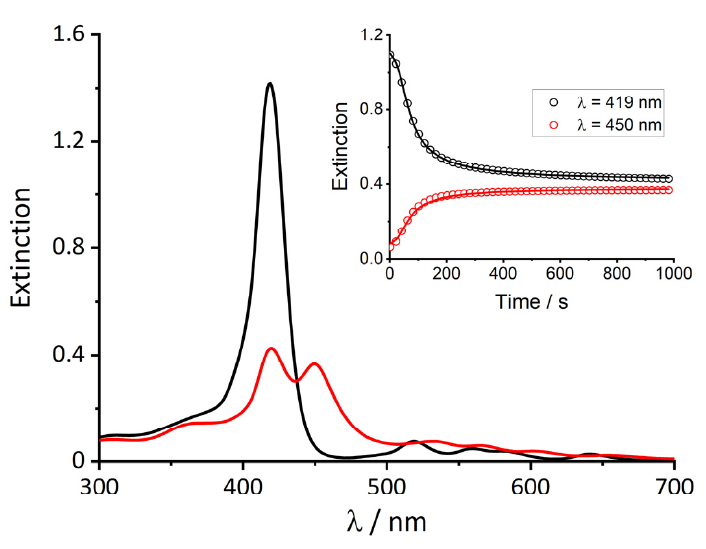
Figure 1. UV/Vis spectra of monomeric t-H 2 Pagg no salt added (black curve), and t-H 2 Pagg aggregates (red curve) obtained upon addition of NaCl. Inset: kinetic traces recorded for the decrease of monomeric t-H 2 Pagg at λ = 419 nm (black circles) and the formation of t-H 2 Pagg aggregates at λ = 450 nm (red circles). Solid lines represent the result of the global fit obtained with Equation (1) ( k 0 = 0.0036 ± 0.00097 s − 1 , k c = 0.0237 ± 0.0007 s − 1 , m = 4.3 ± 0.6, n = 3.0 ± 0.5). Experimental conditions: [t-H 2 Pagg] = 5 µ M, [NaCl] = 100 mM, phosphate buffer 1 mM, pH = 7.4, T = 298